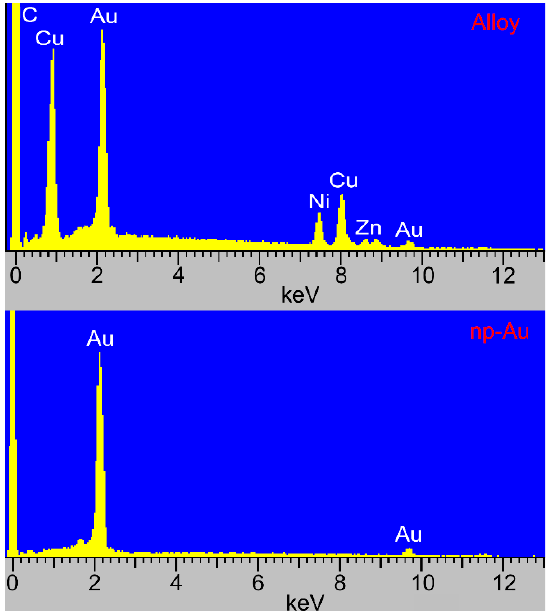
Figure 4. Typical EDX spectra of alloy ( top ) and the np-Au ( bottom ) showing removal of reactive metals present in the alloy after dealloying process.